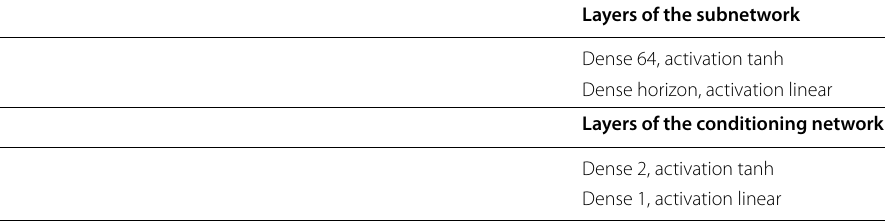
Table 1 The architecture of the subnetwork and the conditioning network in the used cINN